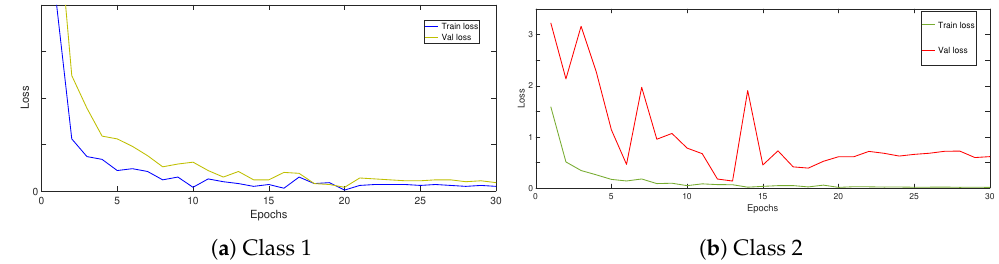
Figure 4. Example of training/validation loss curves: ( a ) well-converged, ( b ) badly